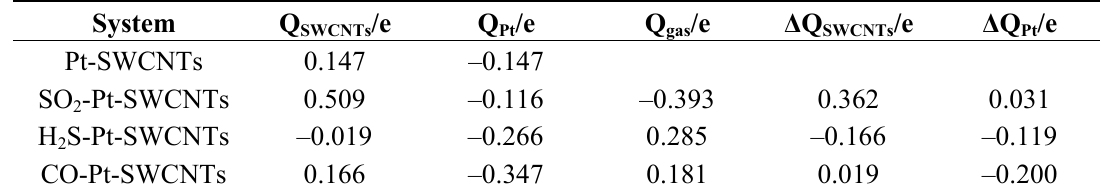
Table 3. Electrical structure parameters of the adsorption